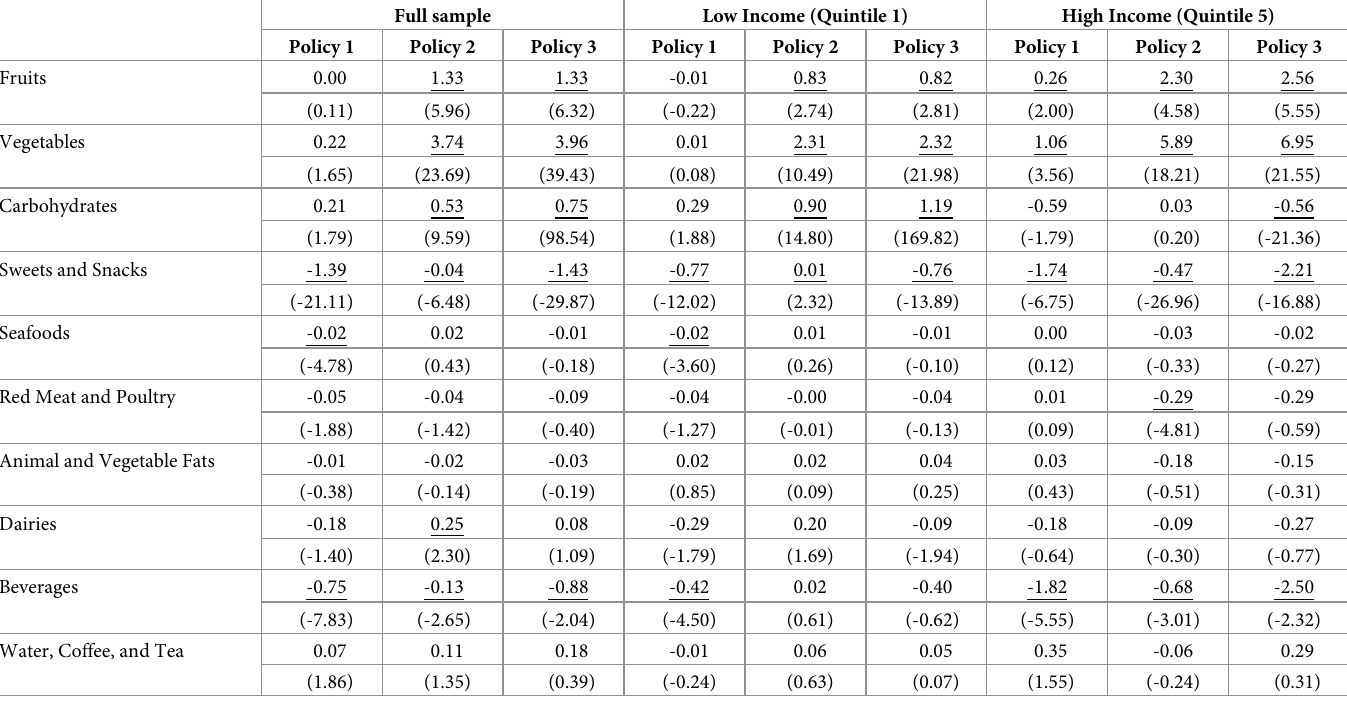
Table 4. Average change in household purchases in kilograms or liters per